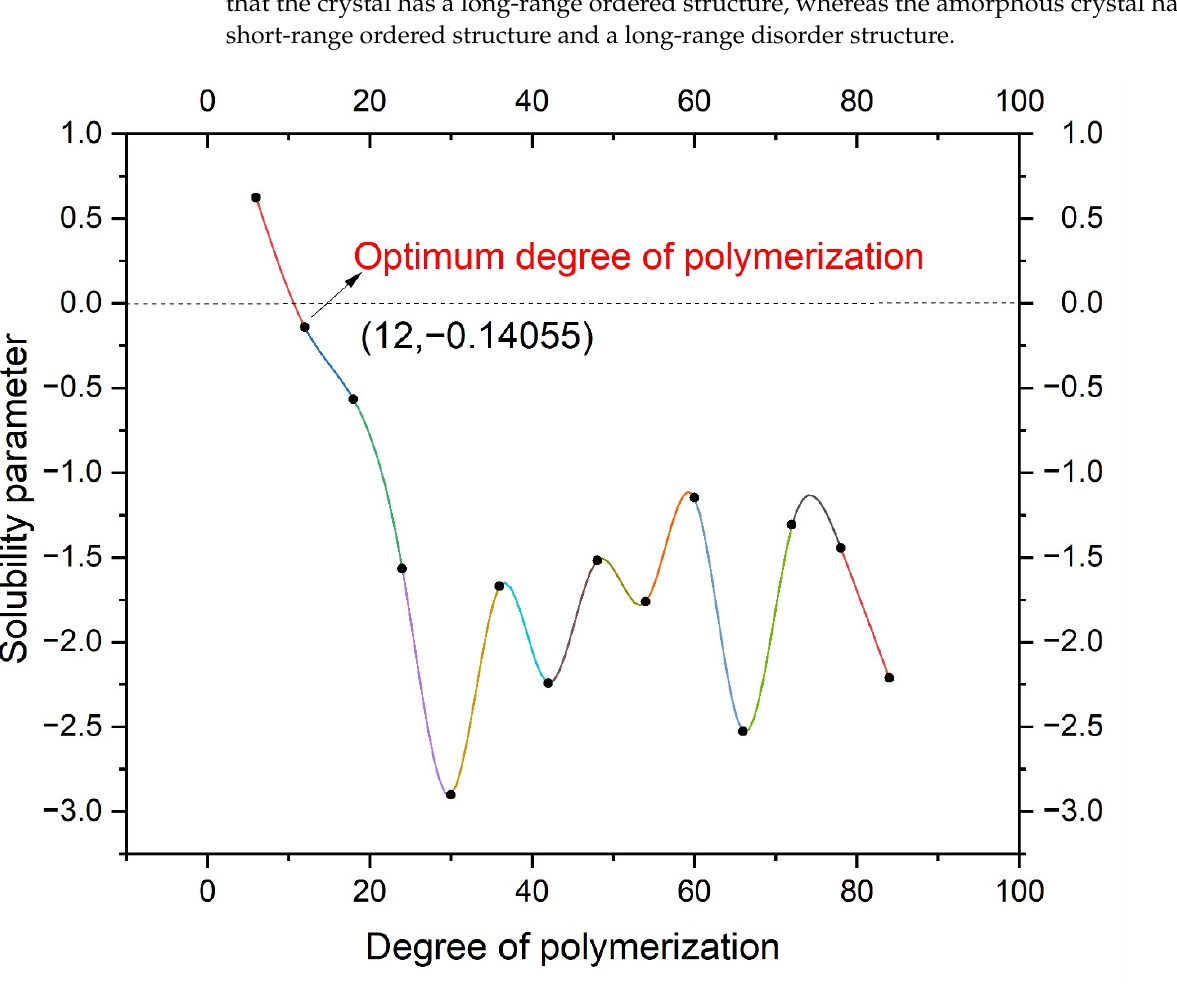
Table 4. Solubility parameters of different PE molecules.